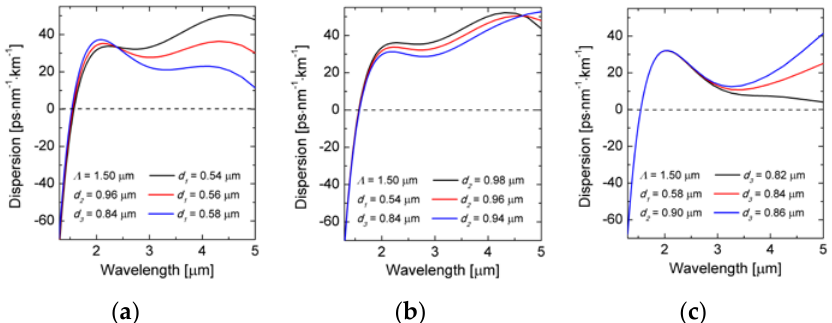
Figure 4. Dispersion characteristics for the lattice constant Λ = 1.5 μm and varied diameters of air-holes in ( a ) the first row d 1 , ( b ) the second row d 2 , and ( c ) the other rows of the photonic cladding d 3 .